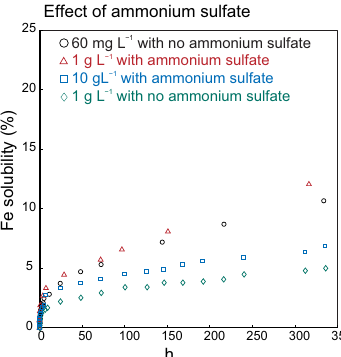
Figure 1. Comparison of Fe solubility in solution (%) mea- sured at two different dust / liquid ratios of 1gL − 1 (red triangles; pH = 2) and 10gL − 1 (blue squares; pH = 2) in 0.05molL − 1 sul- furic acid solution with 1molL − 1 (NH 4 ) 2 SO 4 ( I =3.15molkg − 1 ), and dust / liquid ratios of 60mgL − 1 (black circles; pH = 2.1) and 1gL − 1 (green diamonds; pH = 2.1) in 0.005molL − 1 sulfuric acid solution without (NH 4 ) 2 SO 4